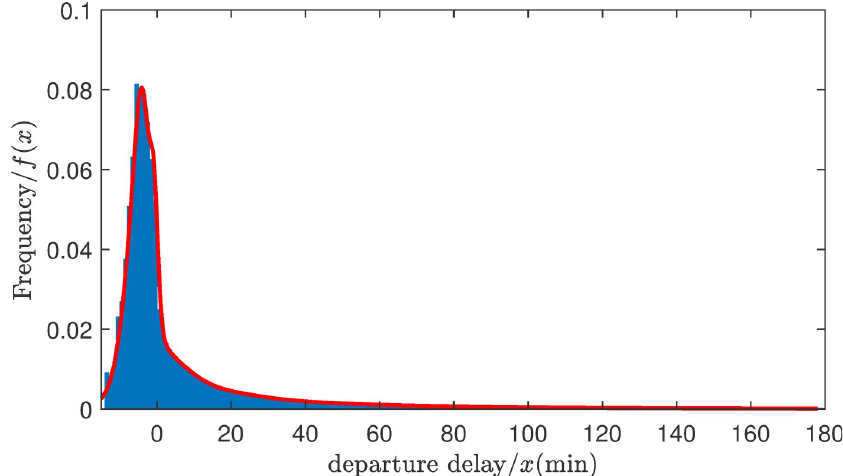
Fig 3. Histogram of the frequency distribution of the departure delay and the probability density function of the departure delays.